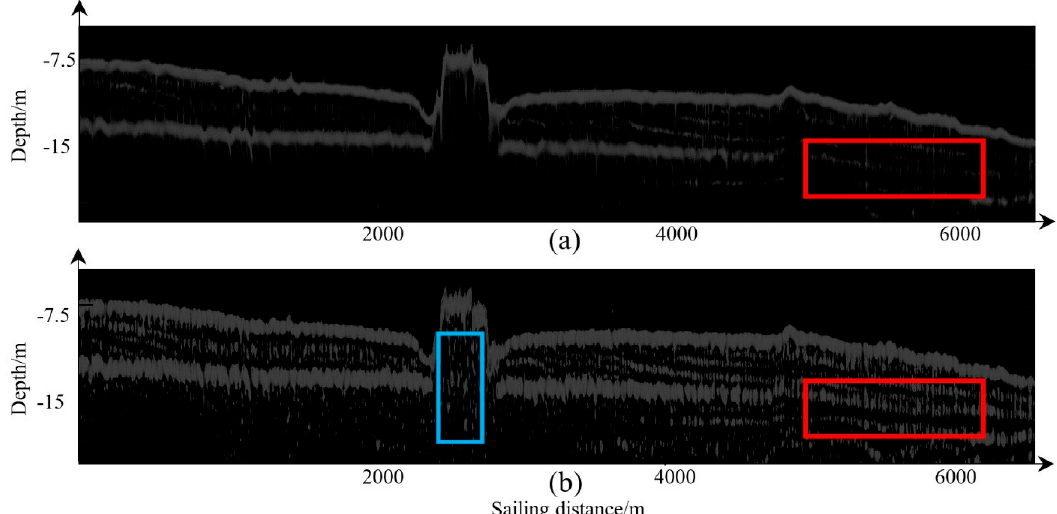
Figure 16. The images of S and R B (corresponding to the original image in Figure 9a). ( a ) shows the image of S , and ( b ) shows the image of R B . Different performances of S and R B are shown in the rectangle areas.